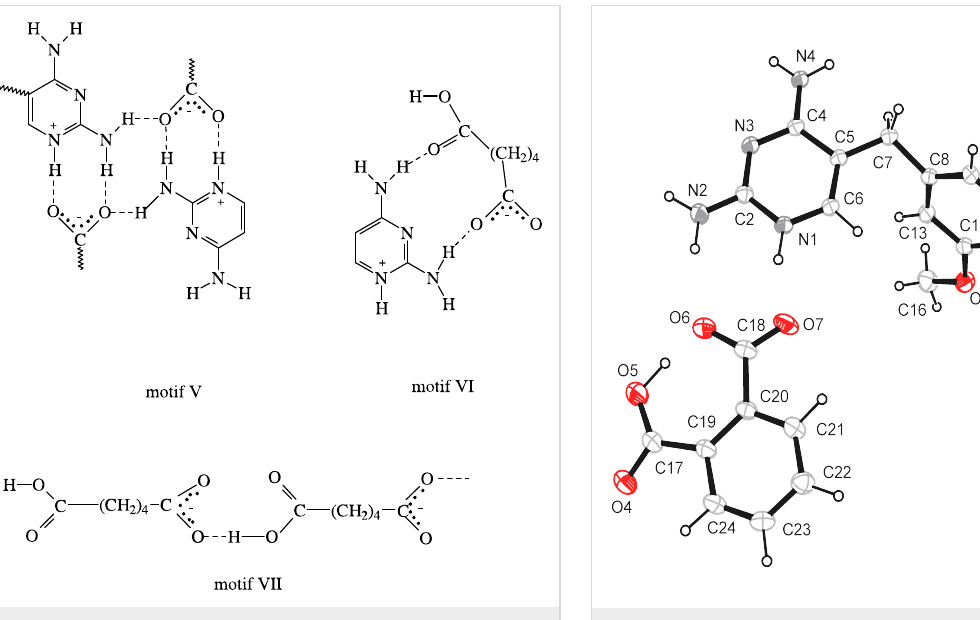
Figure 2: The schematic diagram for the various hydrogen-bonded motifs observed in compound ( 2 ).